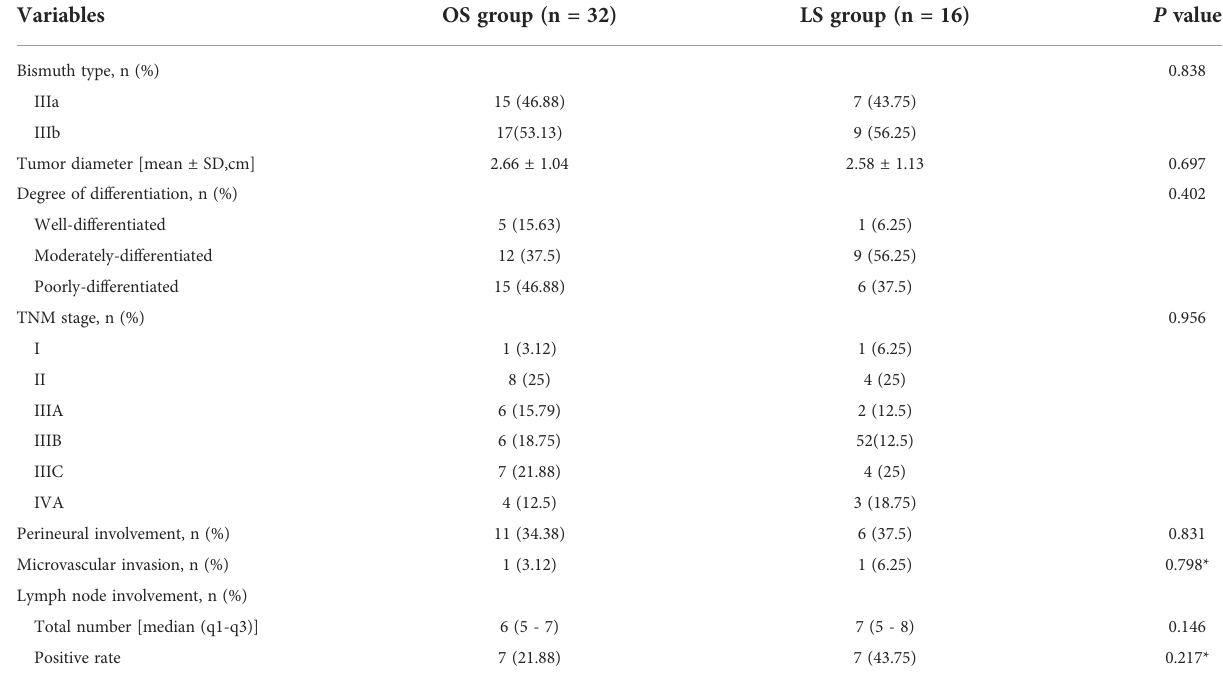
TABLE 2 Pathological fi ndings in the OS and LS